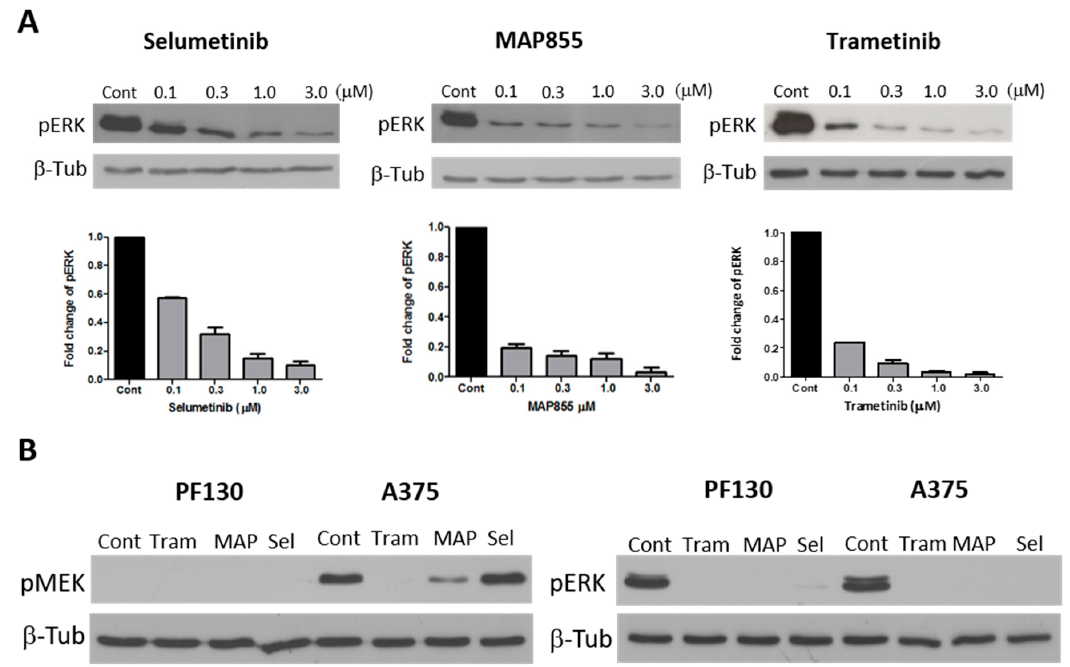
Figure 3. ERK activation and MEK phosphorylation after MEK-inhibitor treatments. ( A ) ERK activation was analyzed by Western blot in PF130 cells after treatment with the MEK inhibitors selumetinib, trametinib or MAP855 for 48 hours. After densitometric analysis, changes in pERK level were normalized to the expression levels of β -tubulin and expressed as fold change compared to untreated controls. Bars represent means ±SE from three independent experiments. ( B ) MEK phosphorylation (SER217/221) was measured after treatment with trametinib (0.3 µM), MAP855 (0.5 µM) or selumetinib (0.5 µM) for 2 hours. Whole blot can be found at Figures S2 and S3.